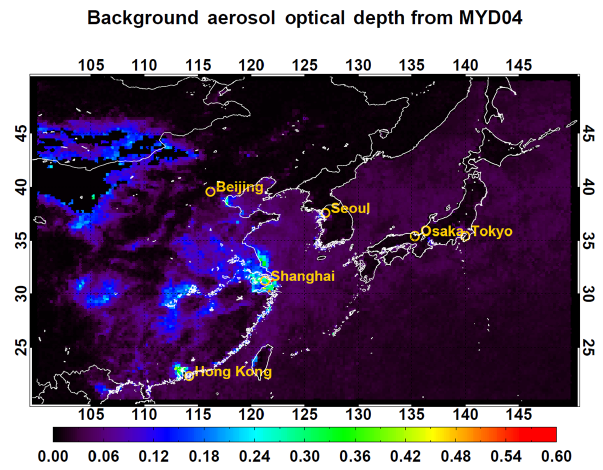
Figure 4. Absolute minimum AOD at 550nm obtained from MODIS level 2.0 products (MYD04_Lv2.0) from 2006 to 2012 at 0.25 ◦ × 0.25 ◦ resolution. Yellow circles indicate the location of well-known urban areas over northeast